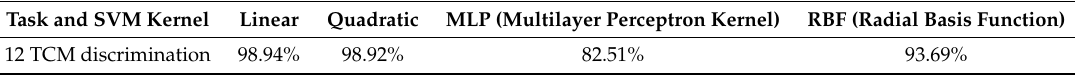
Table 3. Prediction accuracy of SVM with different kernels in offline mode.